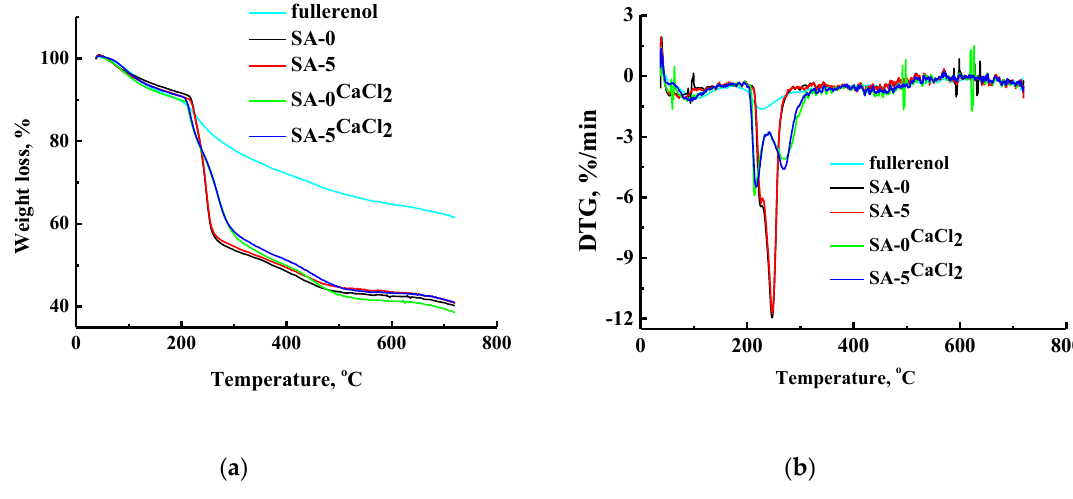
Figure 9. ( a ) TG and ( b ) DTG curves for fullerenol, SA-0, SA-5 and cross-linked SA-0 CaCl2 and SA-5 CaCl2 membranes.